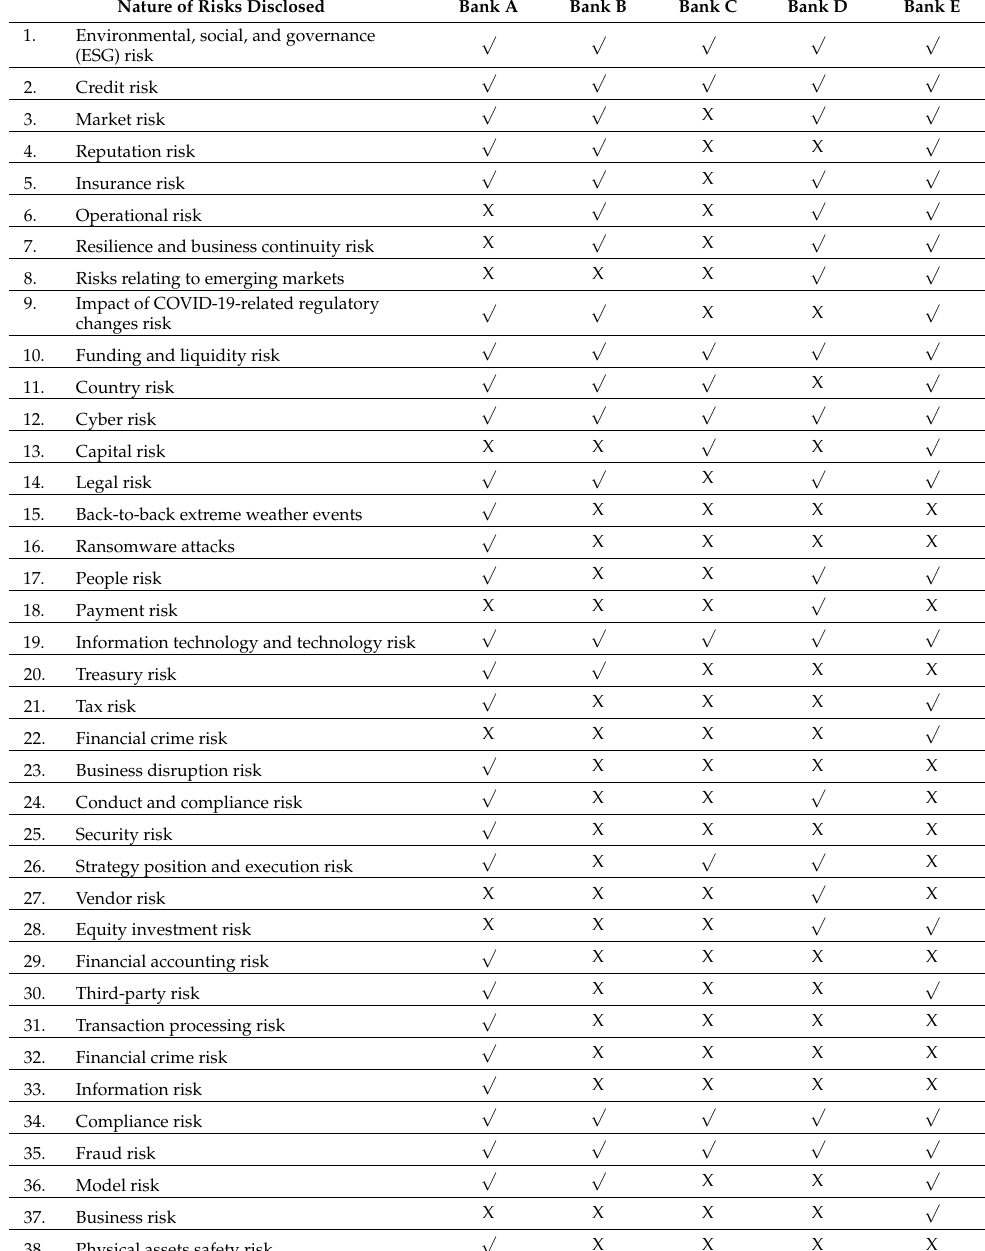
Table 2. Nature of Risk